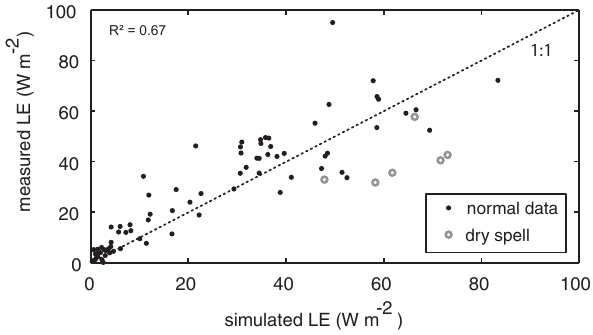
Figure 5. A one-to-one comparison of weekly averages of latent heat (LE) for the POPFULL site, between the model outputs and the measured values. The dotted line is the 1:1 line. Weeks 18–23, which represent the dry spell, are highlighted as grey circles.